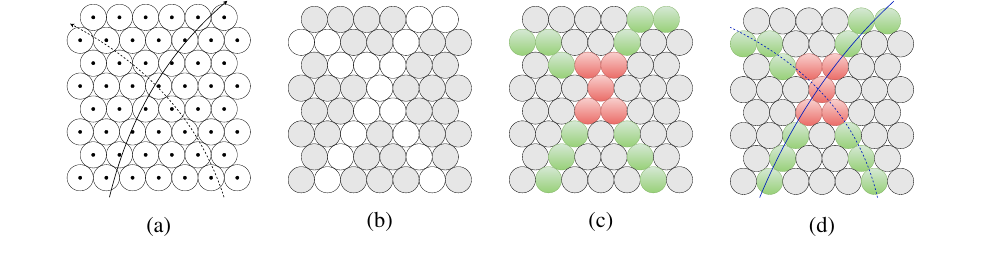
Figure 2: Illustration of the cellular automaton workflow. (a) Particles traverse the detector. (b) Cells corresponding to detector hit are marked as active. (c) Active cells are classified as unambiguous (green) or ambiguous (red). (d) Track fits are used to resolve ambiguities and merge tracklets.